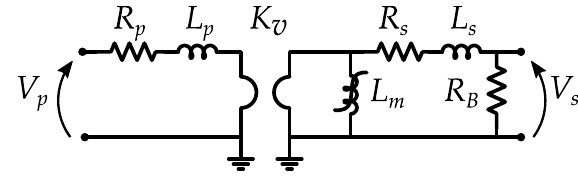
Figure 3. Voltage transformer equivalent circuit. Table 1. Voltage transformer equivalent circuit parameters.